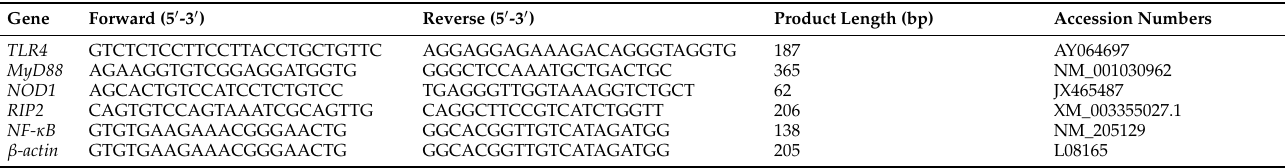
Table 2. Primer sequences used for real-time